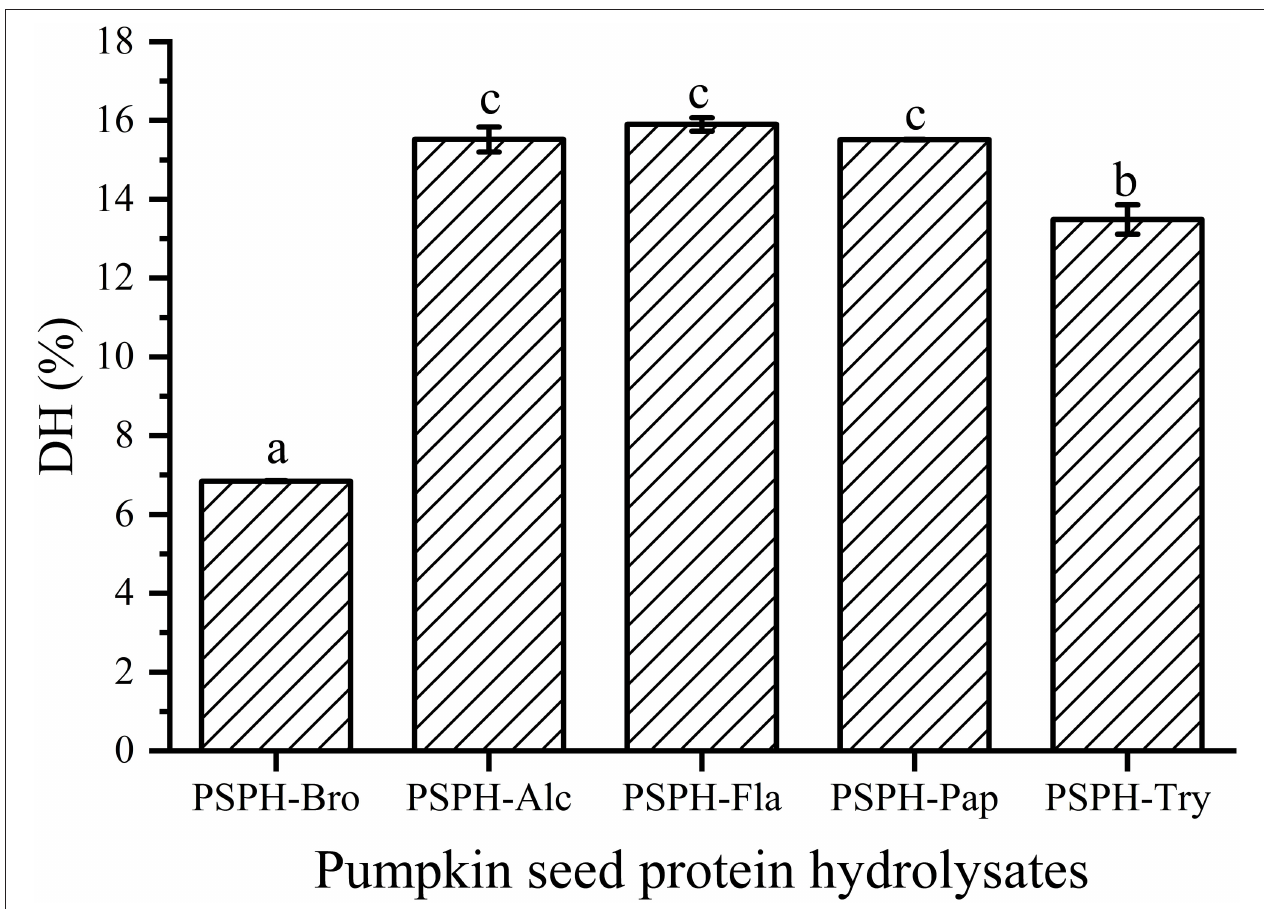
FIGURE 2 | Degree of hydrolysis (DH) of pumpkin seed protein hydrolysates produced with bromelain (PSPH-Bro), alcalase (PSPH-Alc), flavourzyme (PSPH-Fla), papain (PSPH-Pap), trypsin (PSPH-Try) after hydrolysis 3h in a 2% (w/w) enzyme to substrate ratio. Different letters represent significantly different mean values with P <